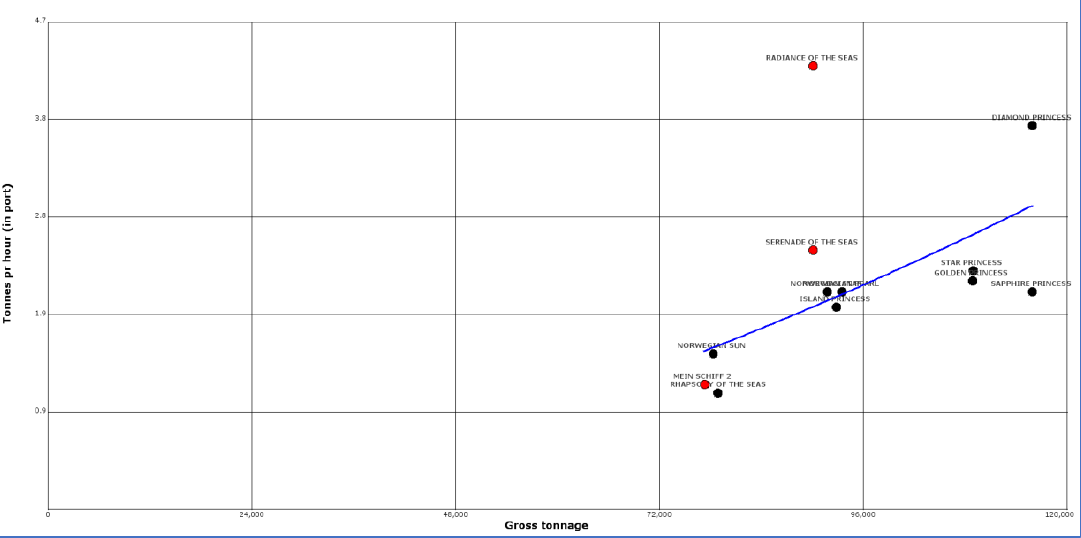
Table 2. Multivariate regression model for hotel functions.